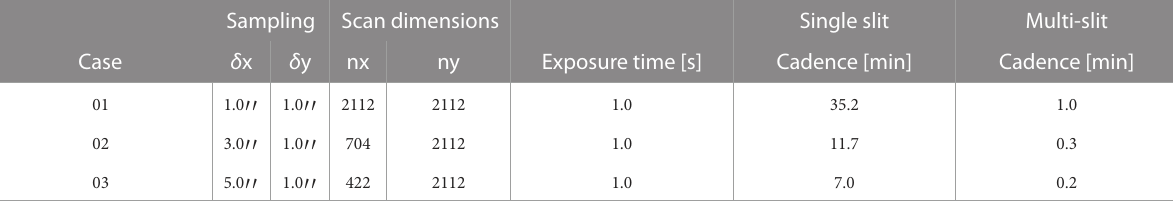
TABLE1 Cadenceperformanceforafull-diskspectrographto1.1 R ⊙